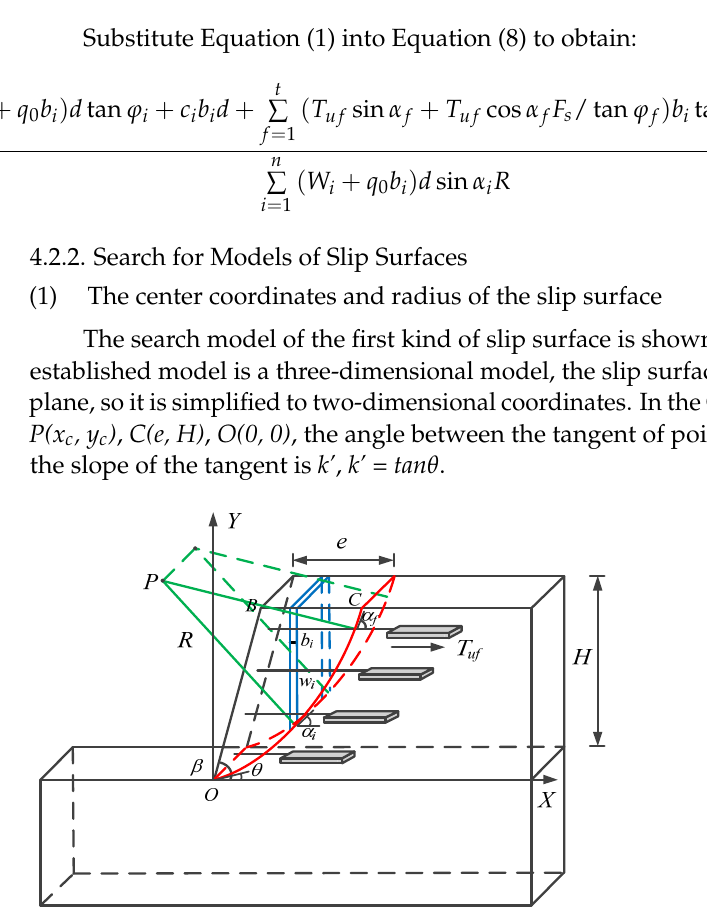
Figure 12. Search model of the first kind of slip surface.